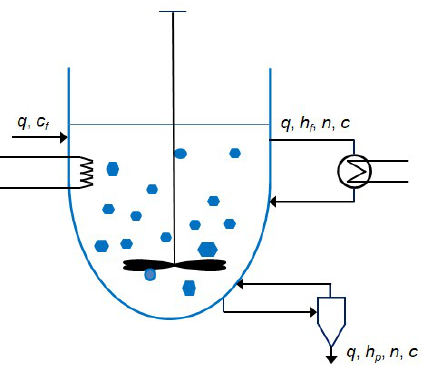
Figure 1. A scheme of continuous crystallizer with ideal mixing, isothermal operation and constant overall volume (liquid phase and growing crystals). The classification